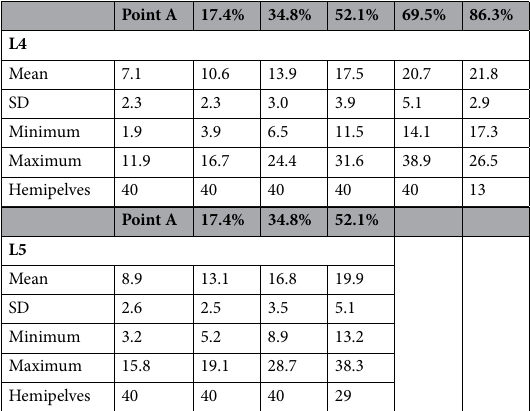
Table 1. Details on distances (in millimeters) between the SIJ and the lateral borders of the ventral branches of L4 and L5. Point A represents the basic reference point at the linea terminalis. Percentages represent the 1 cm measurement points relative to the total length of the SIJ starting from reference point A in a posterior direction (Inlet